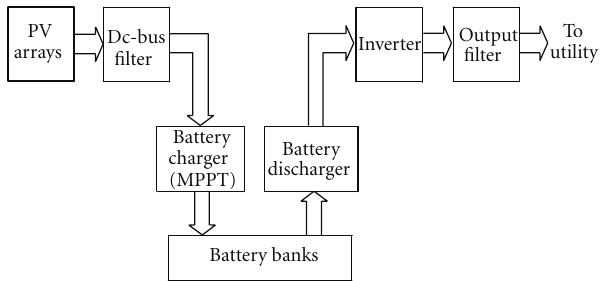
Figure 1: A block diagram of a conventional grid-connection PV system.